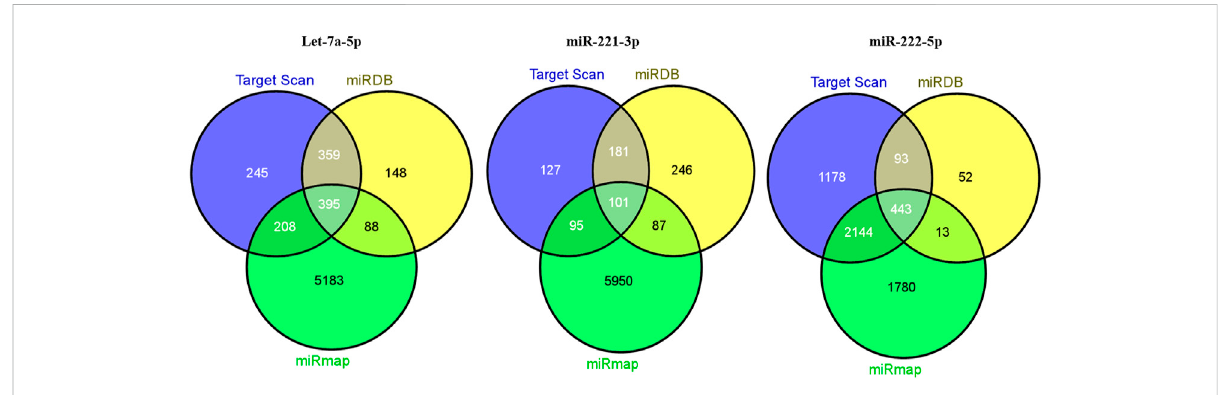
FIGURE 7 Venn diagram for target genes prediction for miRNA signature.